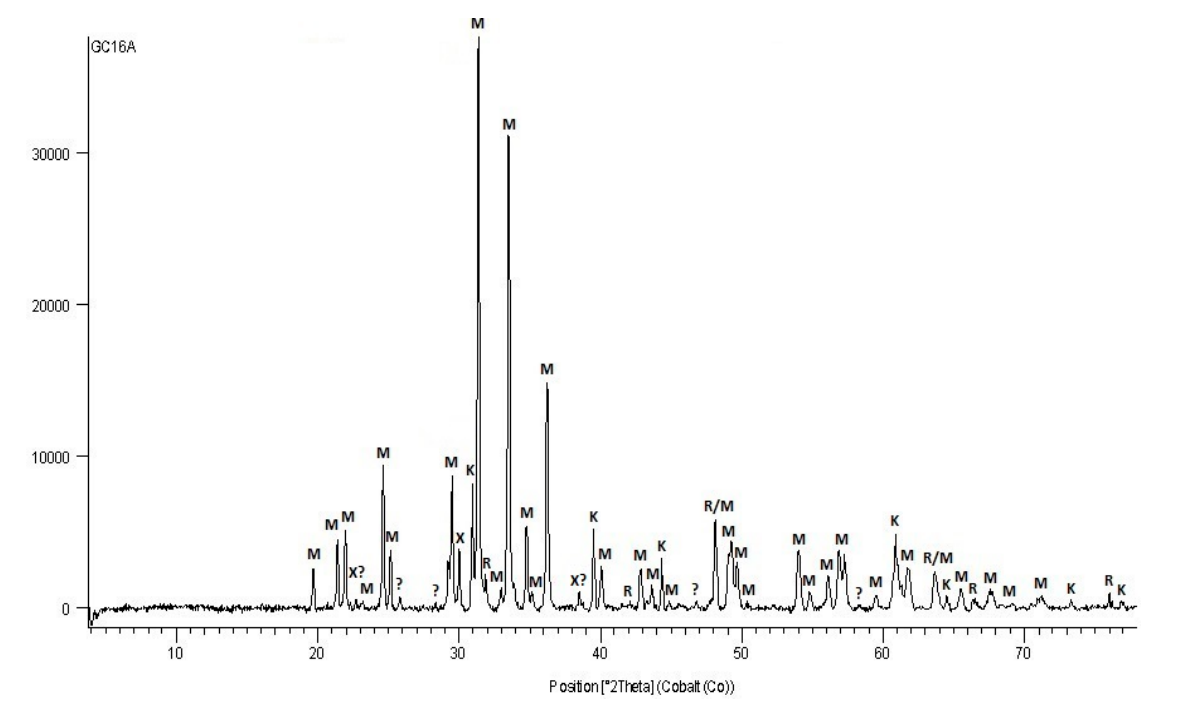
Figure 6. Diffractogram of monazite concentrate (Sample Bngk 21). M—monazite; X—xenotime; K—cassiterite; R—rutile; ?—unidentified peak, probably Ti-phases.